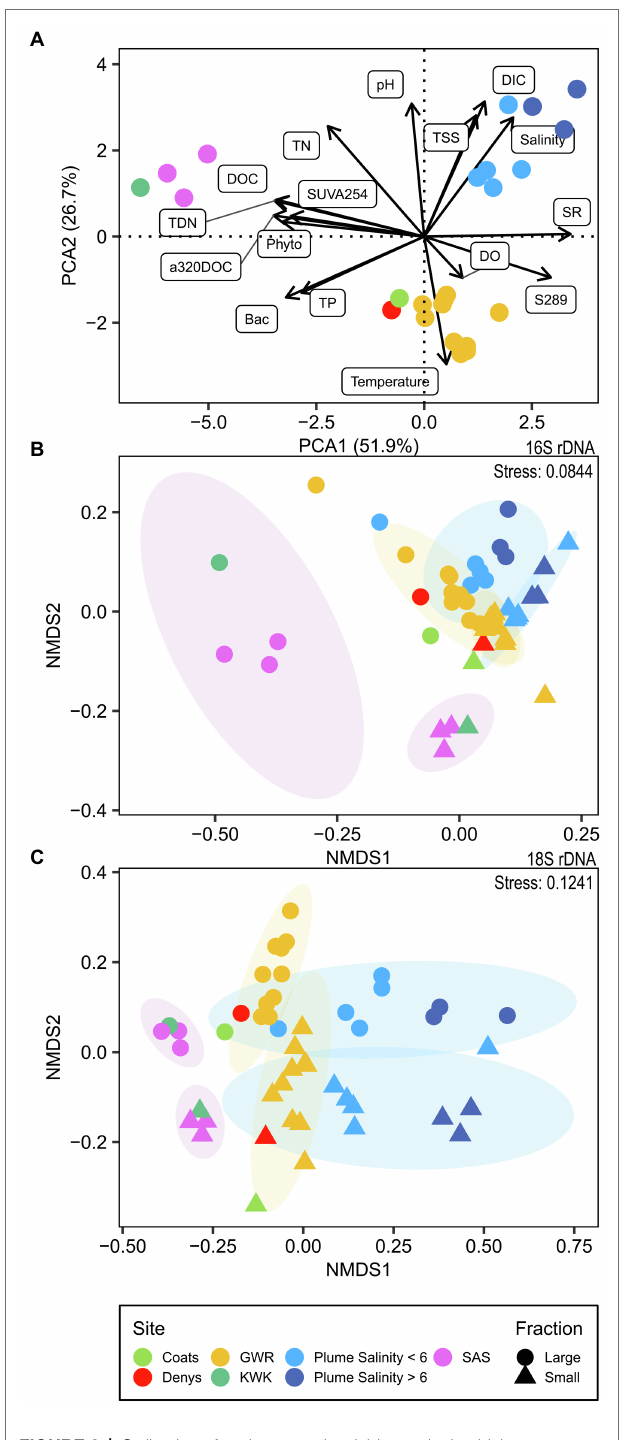
FIGURE 2 | Ordination of environmental variables and microbial communities. (A) Principal component analysis, scaling type 1, of standardized physico-chemical parameters; (B) NMDS based on Bray–Curtis distance for the bacterioplankton community (16S rDNA); (C) NMDS based on Bray–Curtis distance for the microbial eukaryotes (18S